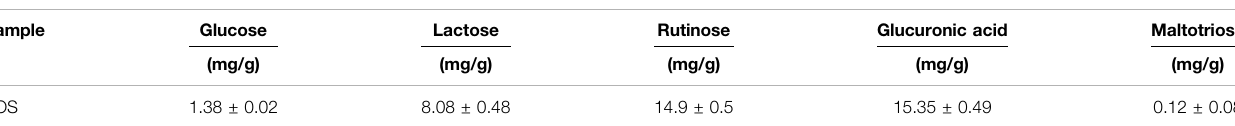
TABLE 2 | The fi ve sugars contents of